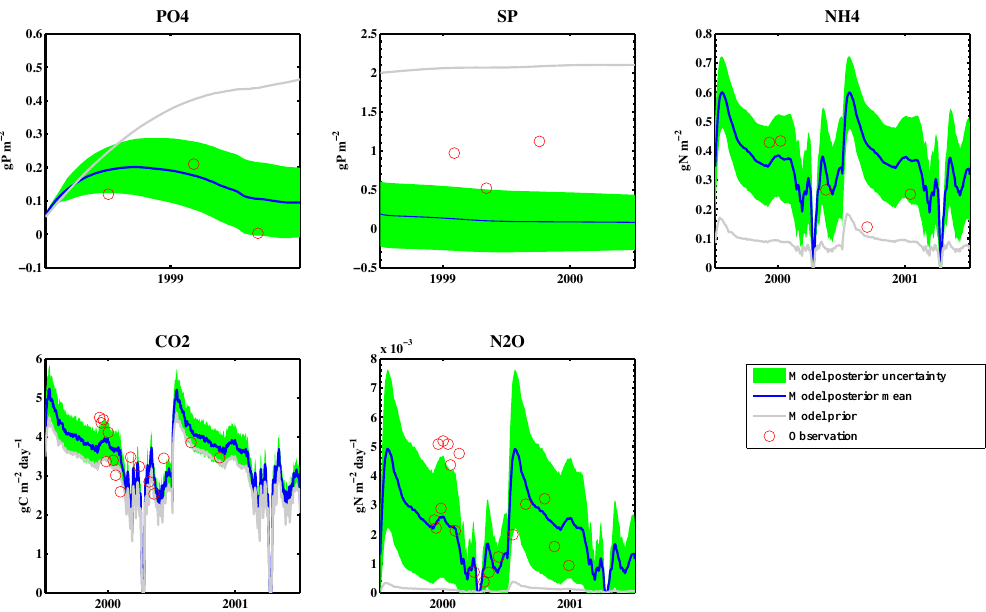
Figure 4. Model performance at Tapajos National Forest, Para, Brazil. Overall, the calibrated model (blue line) improved predictions over the prior model (gray line) when compared to observations. Green areas indicate the calibrated model